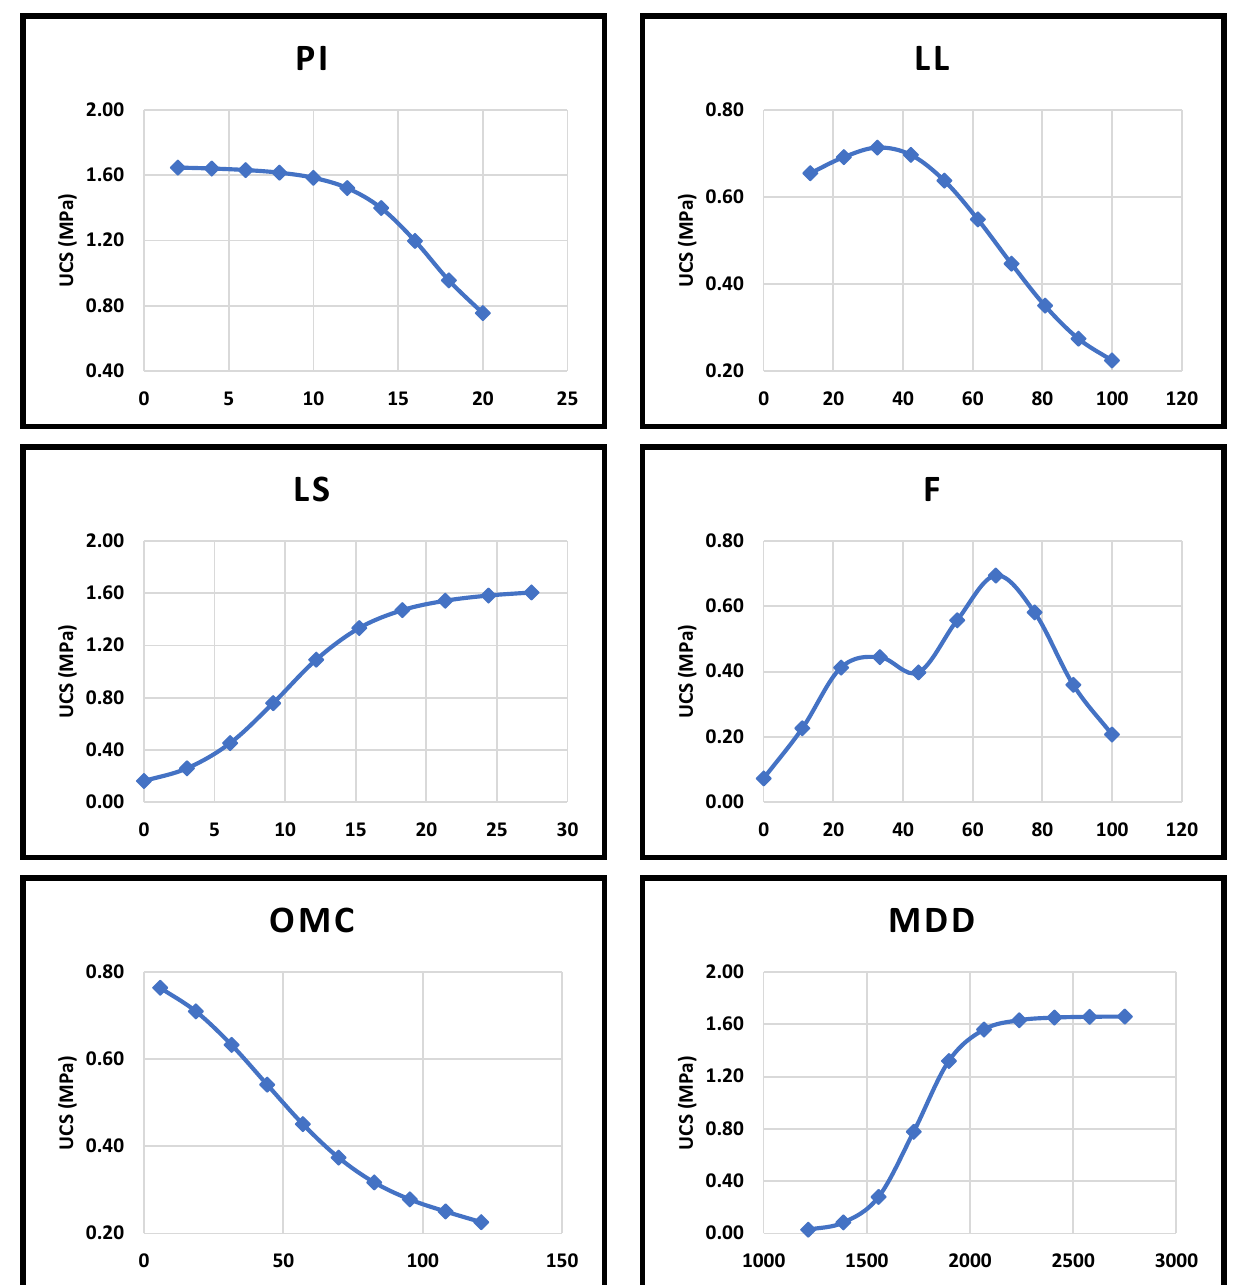
Figure 7. The effect of different parameters on the unconfined compressive strength of unstabilized soil .